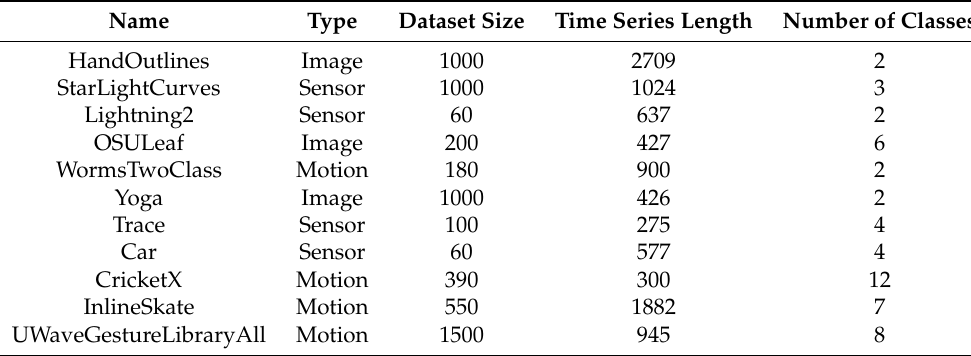
Table 1. The selected datasets from the UCR